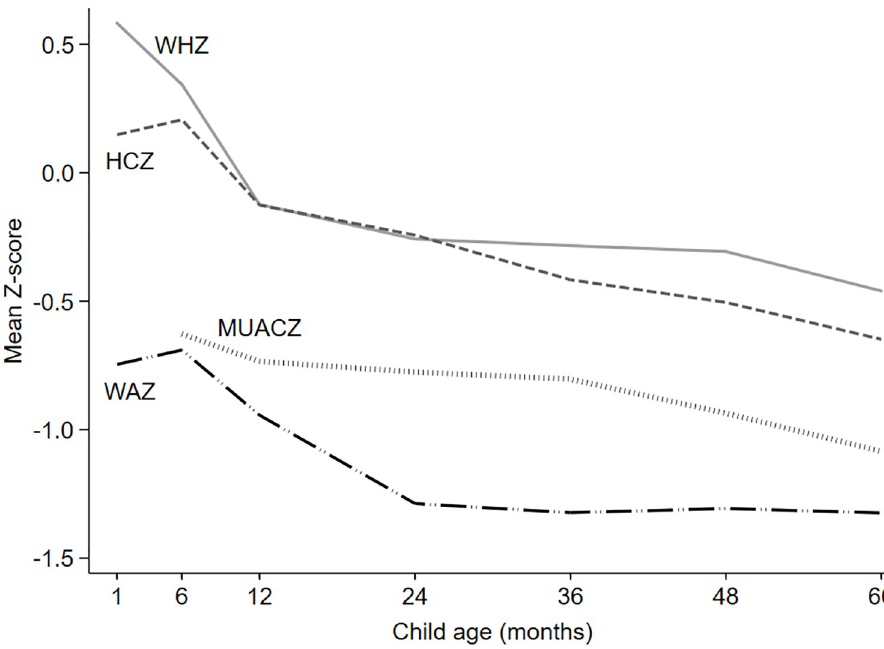
Fig 2. Mean weight-for-age Z-score, weight-for-height Z-score, mid-upper arm-circumference-for-age Z-score, and head circumference-for-age Z-score. At one, six, 12, 24, 36, 48 and 60 months of age, all intervention groups combined. WAZ = weight-for-age Z-score, WHZ = weight-for-height Z-score, MUACZ = mid-upper arm- circumference-for-age Z-score, HCZ = head circumference-for-age Z-score.